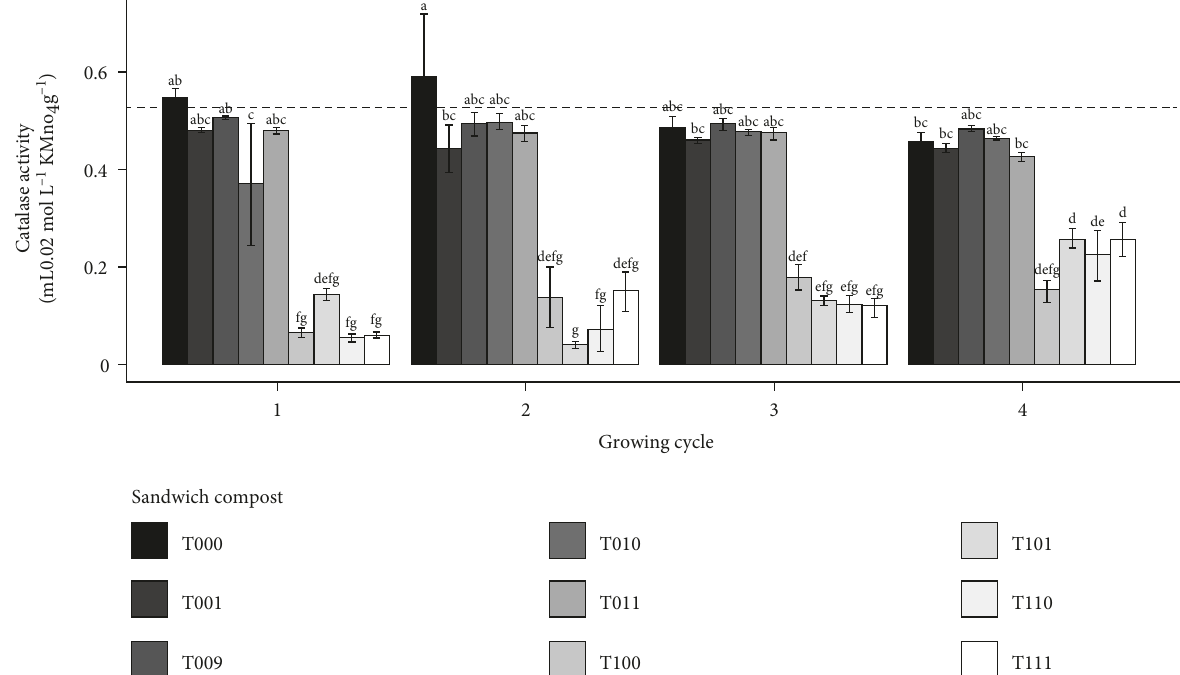
Figure 5: Effect of the growing cycle and Sandwich compost amendments on catalase activity (mL 0.02 molL − 1 KMnO Mean ± standard error with different letters is significantly different at P < 0 . 05 when using DMRT. The dotted line is referred to as the